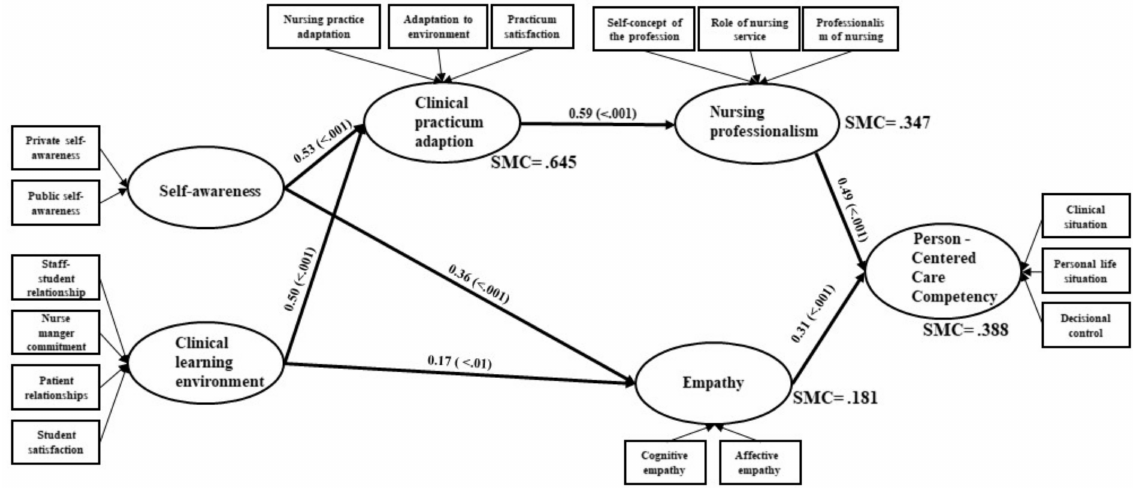
Figure 3. Path diagram of the modified model: Person-centered care competency of nursing students (Standardized regressing coefficients); SMC —squared multiple